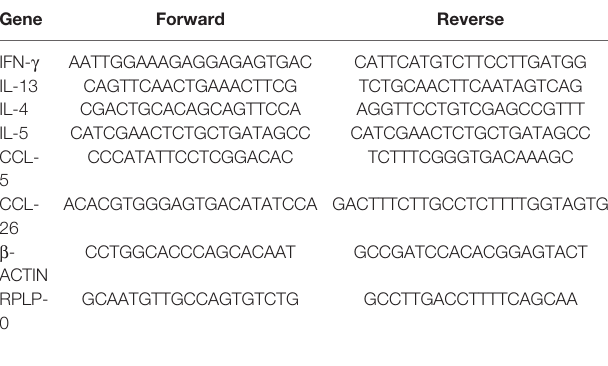
TABLE 1 | Primer sequences employed in the gene expression